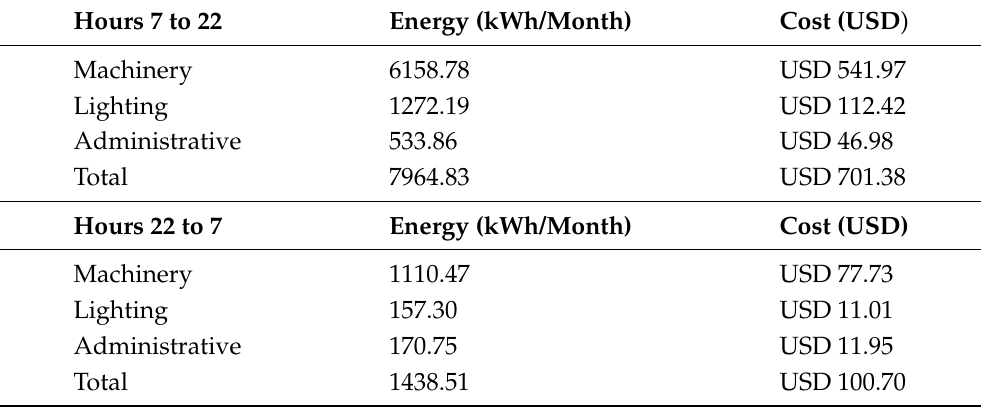
Table 2. Energy balance per period.